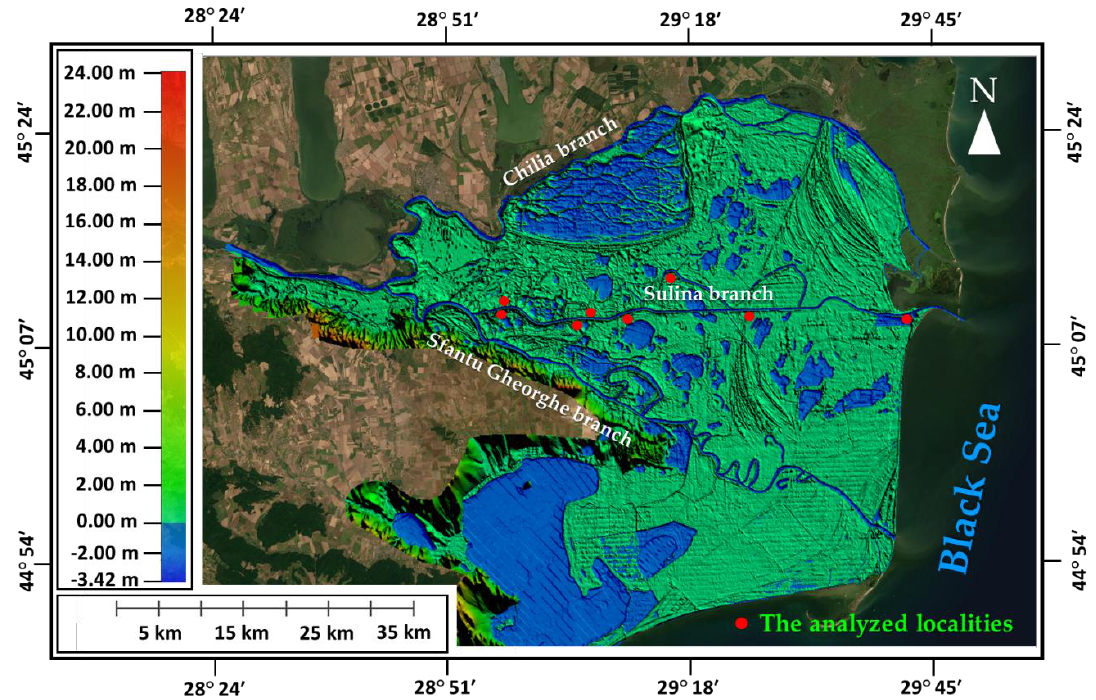
Figure A2. The digital terrain model for the Danube Delta superimposed on the orthophotomaps (the red dots indicate the settlements located along the Sulina branch.